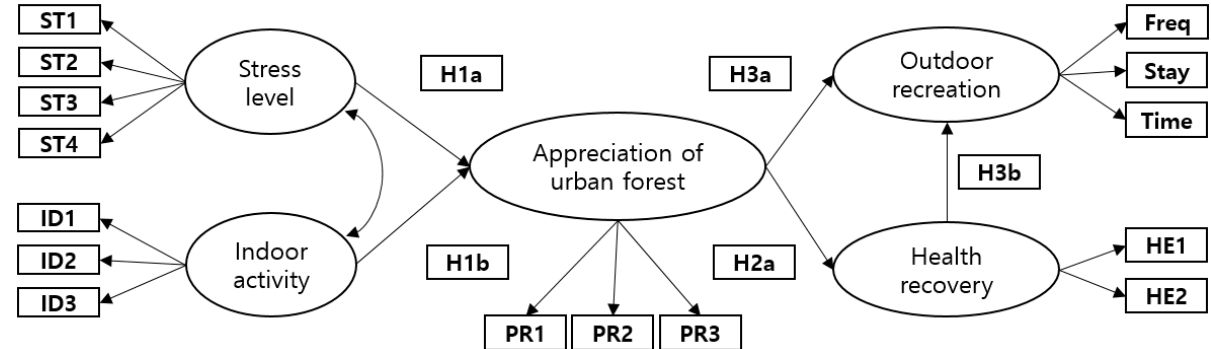
Figure 1. Structural equation modeling diagram (Adapted from [20]). Freq: visit frequency to urban forests; stay: staying time in urban forests; time: transport time to natural areas in urban settings. H1: respondent’s appreciation of urban forests comes from stress level and indoor activity; H2: people’s perception of health recovery during the COVID-19 pandemic comes from appreciation of urban forests; H3: behavior changes in outdoor activity come from both appreciation of urban forests and expectations for health recovery.